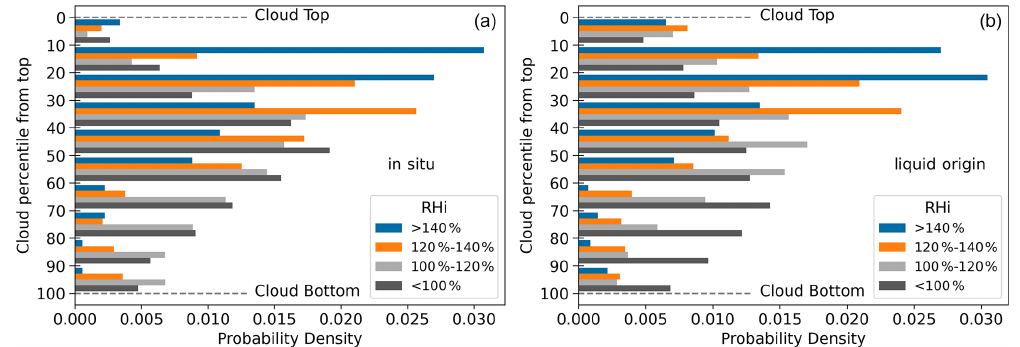
Figure 5. Probability densities of RHi in a relative location to the cloud top. (a) In situ clouds. (b) Liquid-origin clouds. For an in-detail description see Fig.